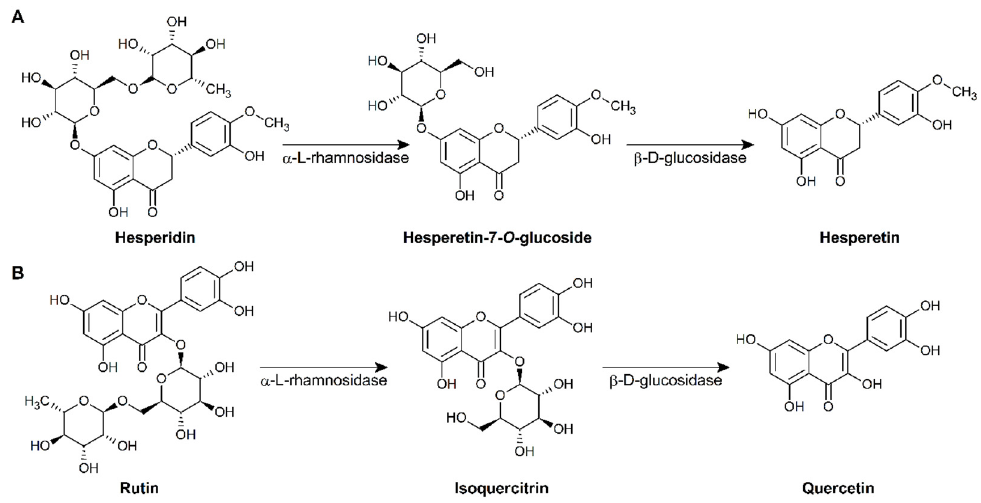
Figure 1. Biotransformation pathway of hesperidin ( A ) and rutin ( B ) by α - L -rhamnosidase and β - D